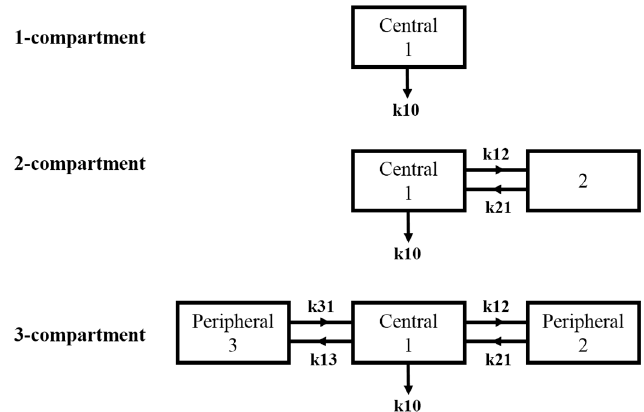
Figure 1. Schematic diagram of compartmental model. Boxes represent non-physiological compartments within which the drug is capable of distributing. Arrows indicate direction of transfer between compartments with ‘k’ indicating a transfer rate constant and the numerals indicating the direction of transport. k10 reflects degradation from a compartment. Table 1. Anatomic and physiological parameters used in the physiologically based pharmacokinetics (PBPK) models; PLN: popliteal lymph node 1 .